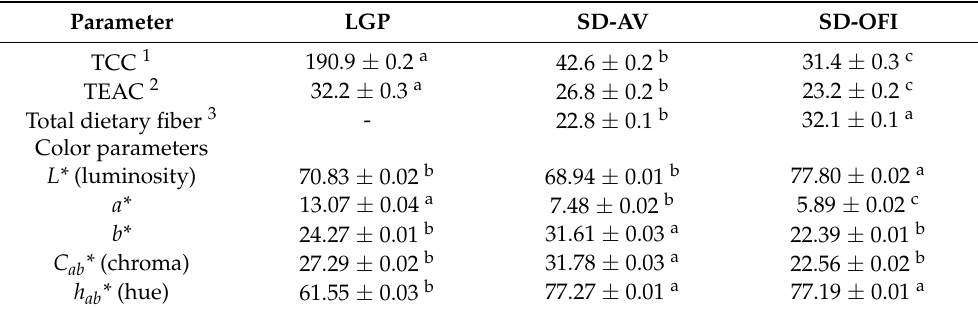
Table 1. Physicochemical characterization of lyophilized guava pulp (LGP) and guava pulp microcap- sules (SD-AV and SD-OFI). Different letters in the same row and column for each parameter indicate a statistical difference ( p < 0.05) between